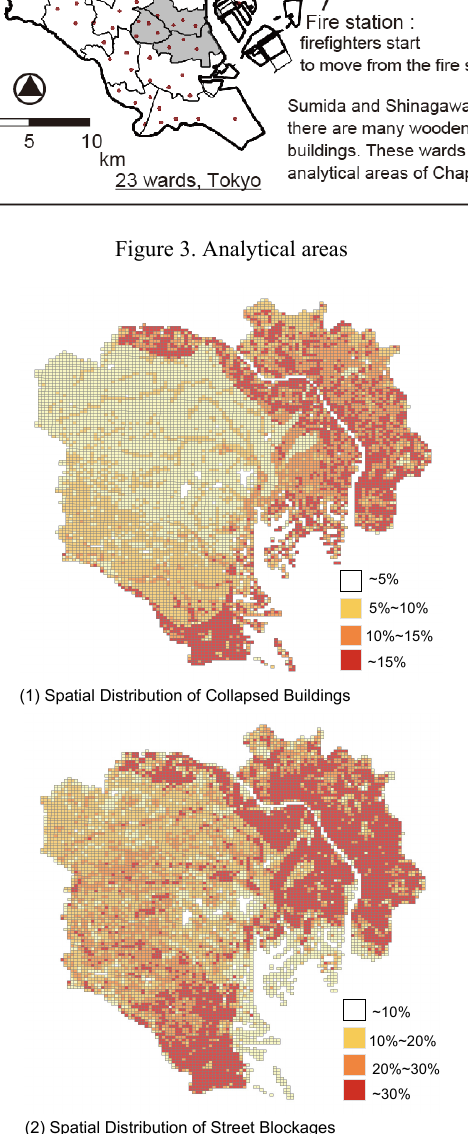
Figure 4. Ratio of collapsed buildings or street blockages to the